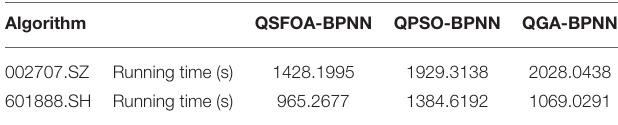
TABLE 4 | Average running time(s) of three models that have been tested for five times.